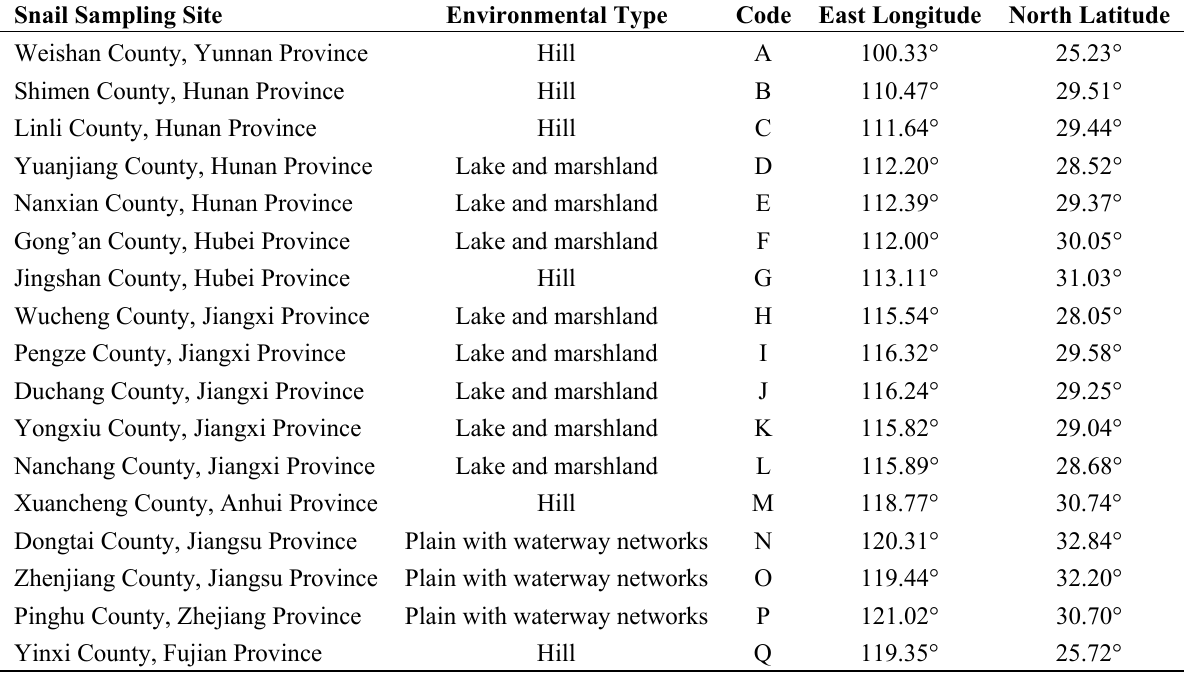
Table 1. Location and environmental types of the snail sampling sites in China